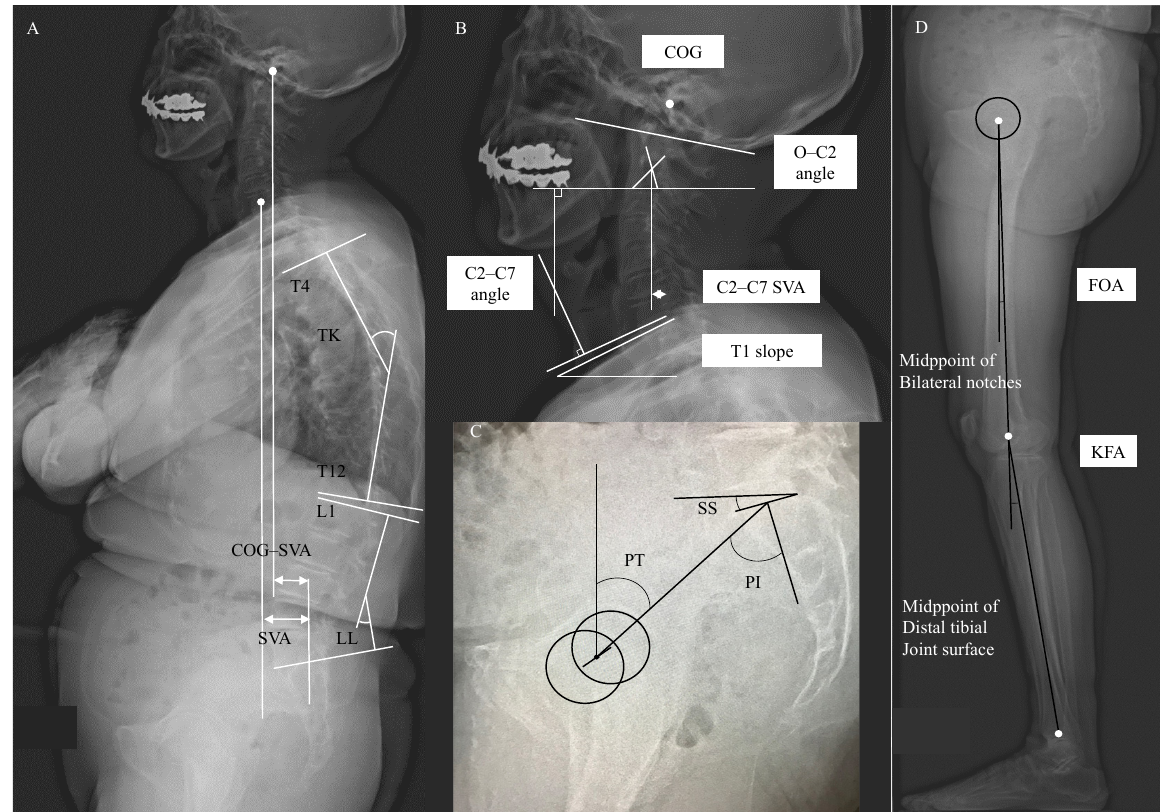
Figure 1. Sagittal alignment parameters in the standing position . ( A , B ) Spinal parameters, O–C2 angle (occipito–C2 angle), C2–C7 angle, C2–C7 sagittal vertical axis (C2–C7 SVA), the center of gravity of the head-posterior superior endplate of S1 (COG–SVA), T1 slope, thoracic kyphosis (TK), lumbar lordosis (LL), and SVA, were measured on a lateral whole-spine radiograph. ( C ) Pelvic parameters, PT (pelvic tilt), sacral slope (SS), and pelvic incidence (PI), were measured. ( D ) Lower-extremity parameters, the femur obliquity angle (FOA) and the knee flexion angle (KFA), were measured. The C2–C7 angle and the T1 slope range from 20–35 ◦ and 13–25 ◦ in healthy subjects, respectively [36,39]. The radiological criteria for ASD, according to the International Spine Study Group, include a frontal Cobb angle > 20 ◦ , SVA > 50 mm, TK > 60 ◦ , and/or PT > 25 ◦ . In healthy subjects, the KFA in standing position was <6 ◦ [38], and the knee joint flexion was defined as >6 ◦